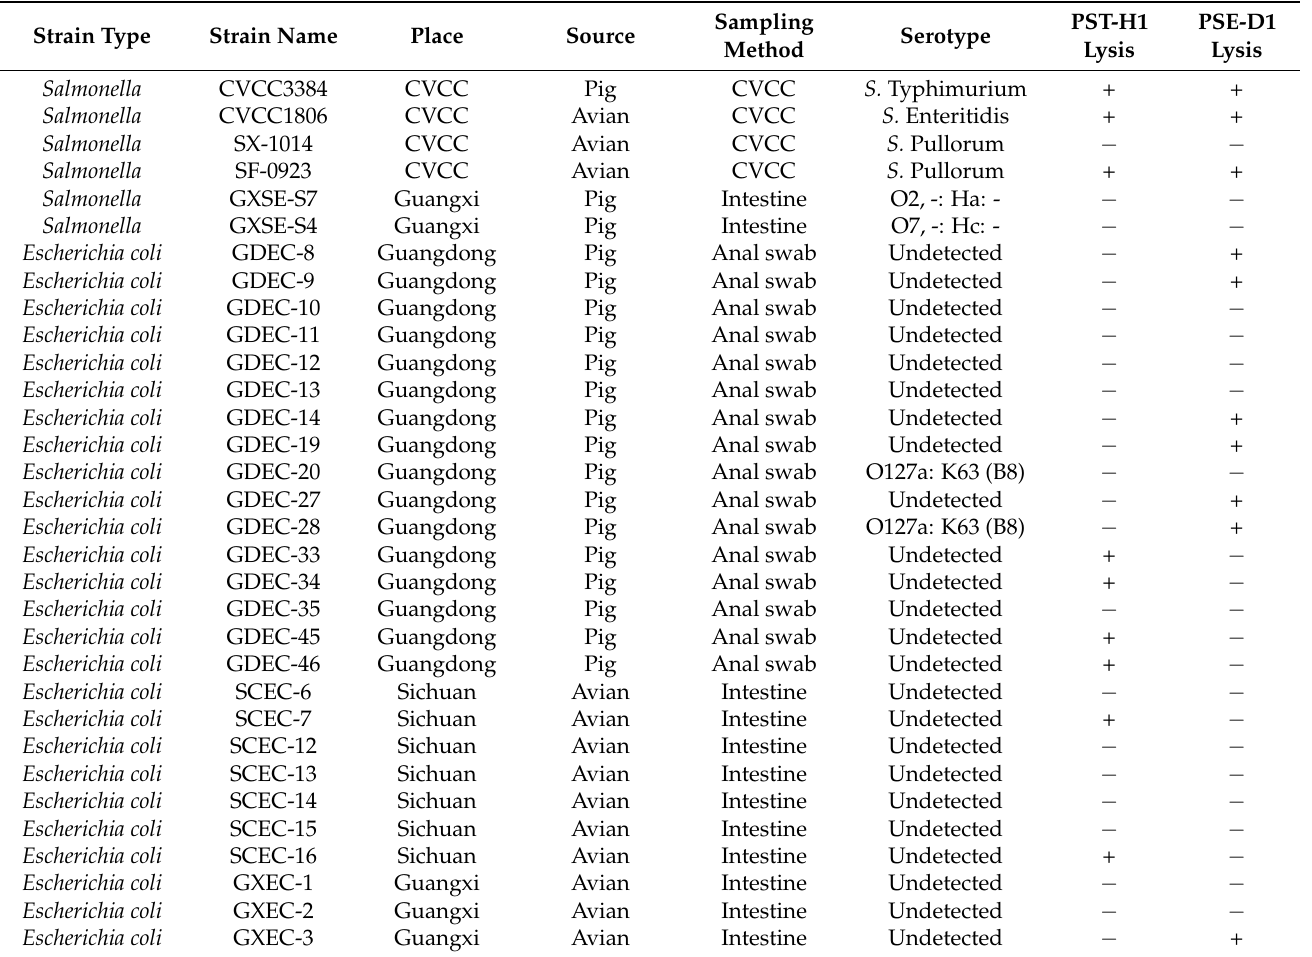
Table 1. Host strains information of phage PST-H1 and PSE-D1.